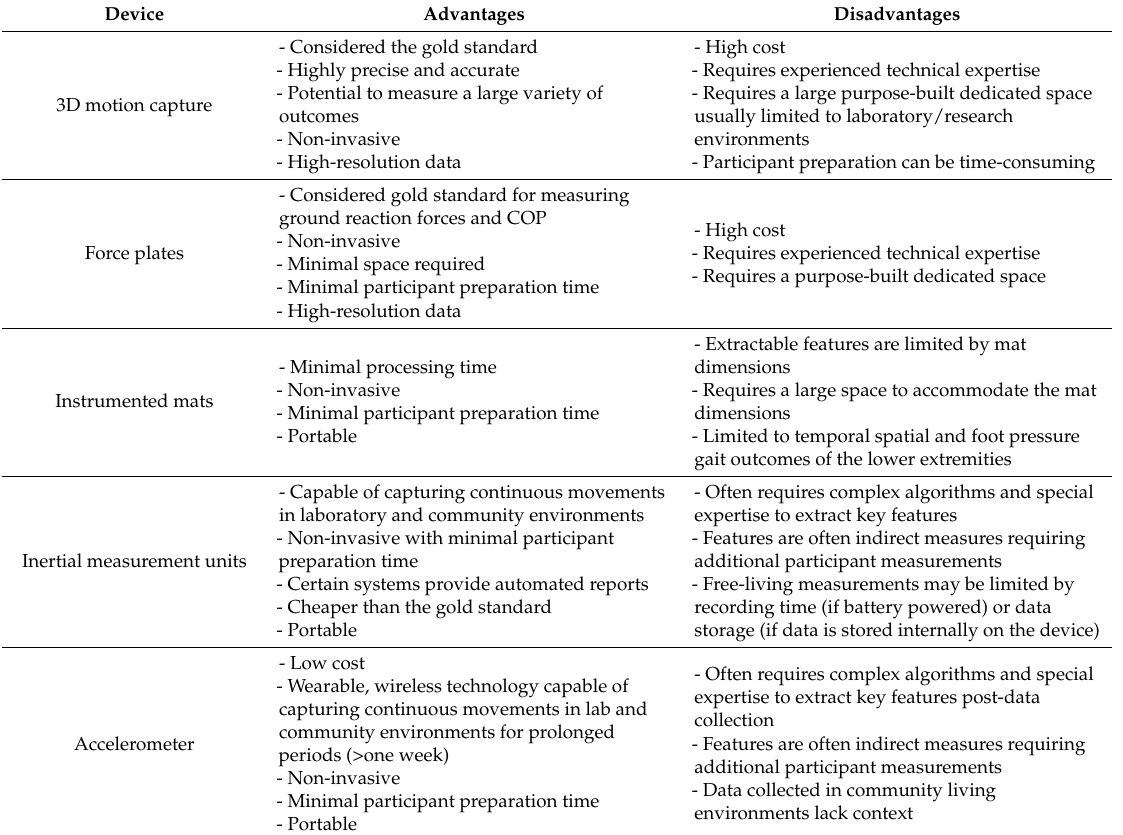
Figure 1. Summary of outcome measures that may be obtained from a quantitative assessment of gait and postural control. Table 1. A summary of the advantages and disadvantages of measurement devices used to quantify gait and postural control. COP: center of pressure.